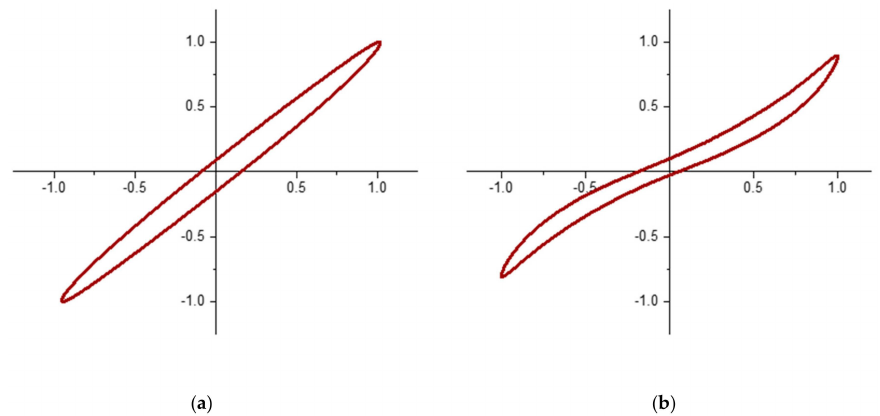
Figure 2. ( a ) Lissajous curve of raw natural rubber, a nearly-linearly viscoelastic material, ( b ) Lissajous curve of standard athletic footwear material, a non-linearly viscoelastic material.